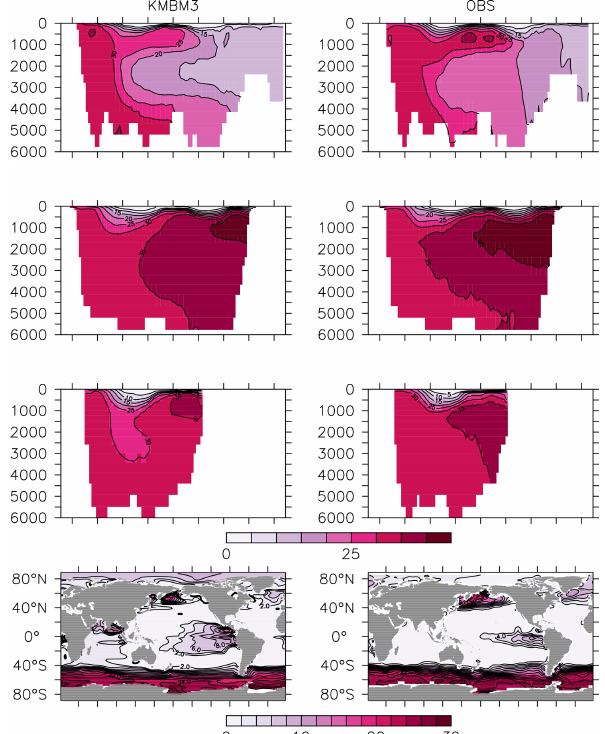
Figure 13. Model (left column) year 2014 NO − (mmolm − 3 ) av- 4 eraged by basin compared to WOA (right column; Garcia et al., 2014b). Regions are as follows: Atlantic (top row), Pacific (second row), Indian (third row) and global surface (bottom